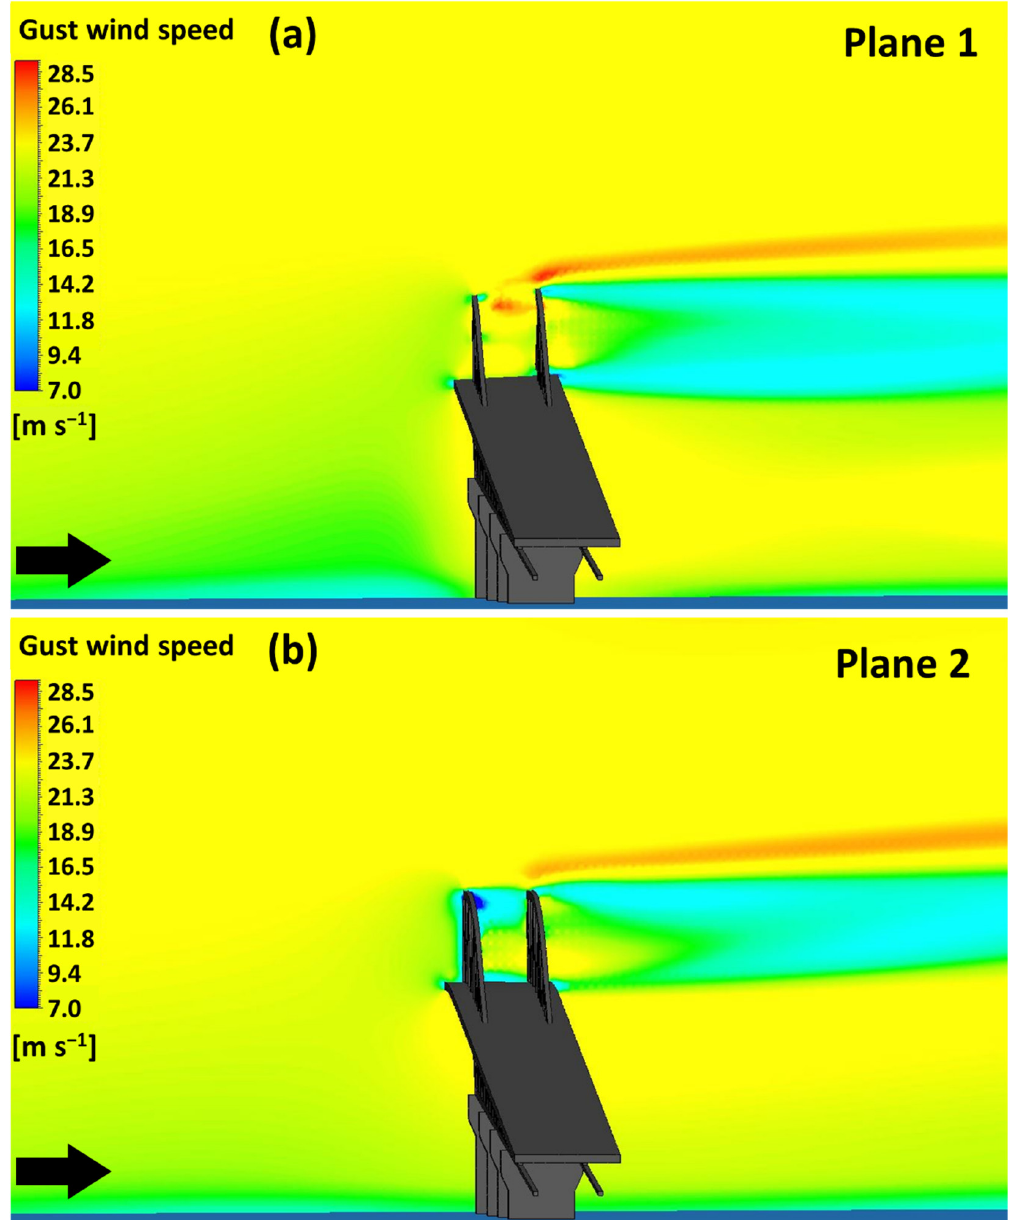
Figure 11. Estimated gust wind speed (Equations (4)–(6)) on the two cross-sectional planes (see Figure 8) of the Auckland Harbour Bridge: ( a ) Plane 1; ( b ) Plane 2.